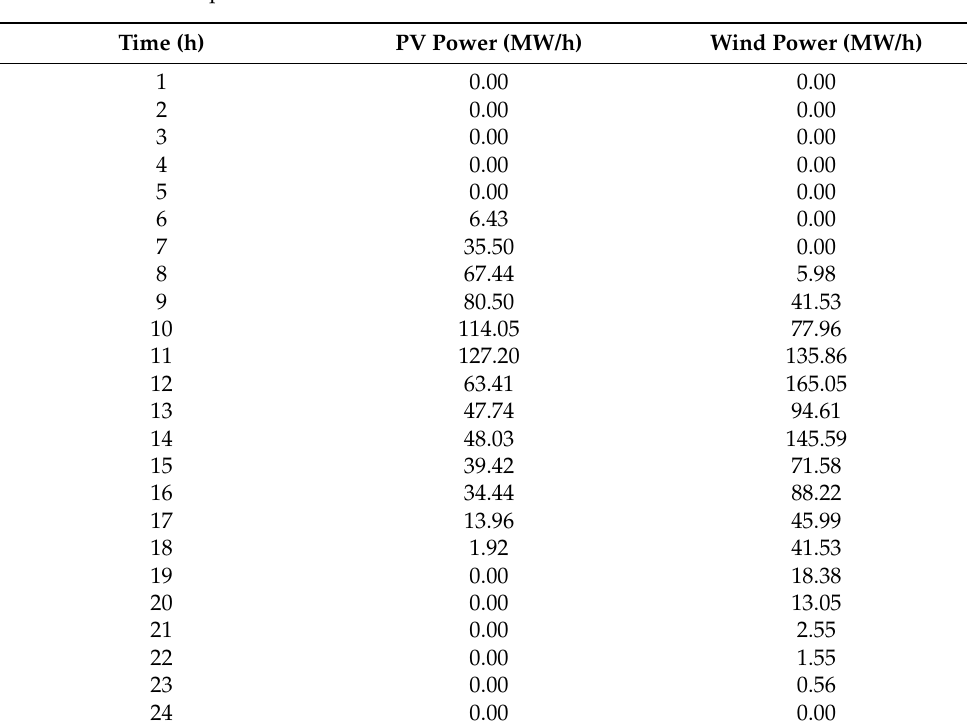
Table A4. Maximum power of RES.